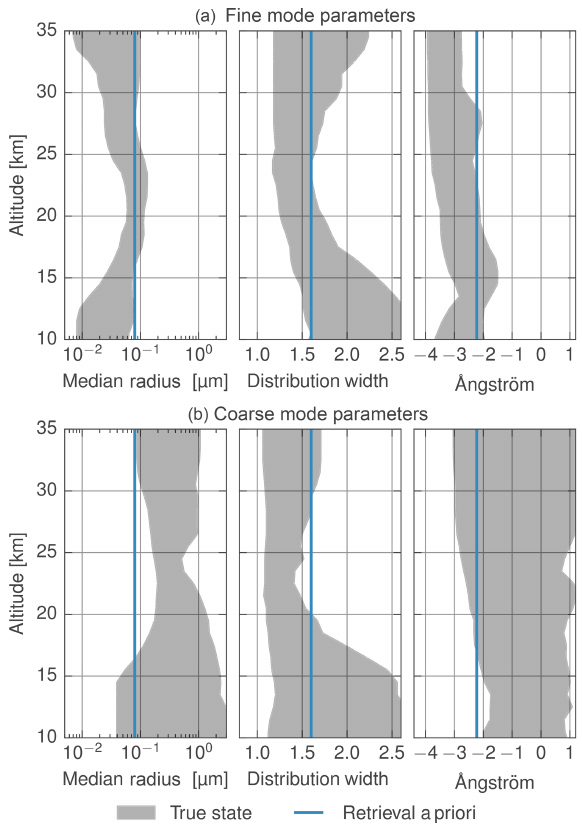
Figure 6. The range of particle sizes tested as a function of altitude. Panel (a) shows the fine-mode parameters and panel (b) the coarse mode. The blue lines show the USask and IUP a priori values as- sumed in the retrievals. The grey shaded region shows the range of values used in the